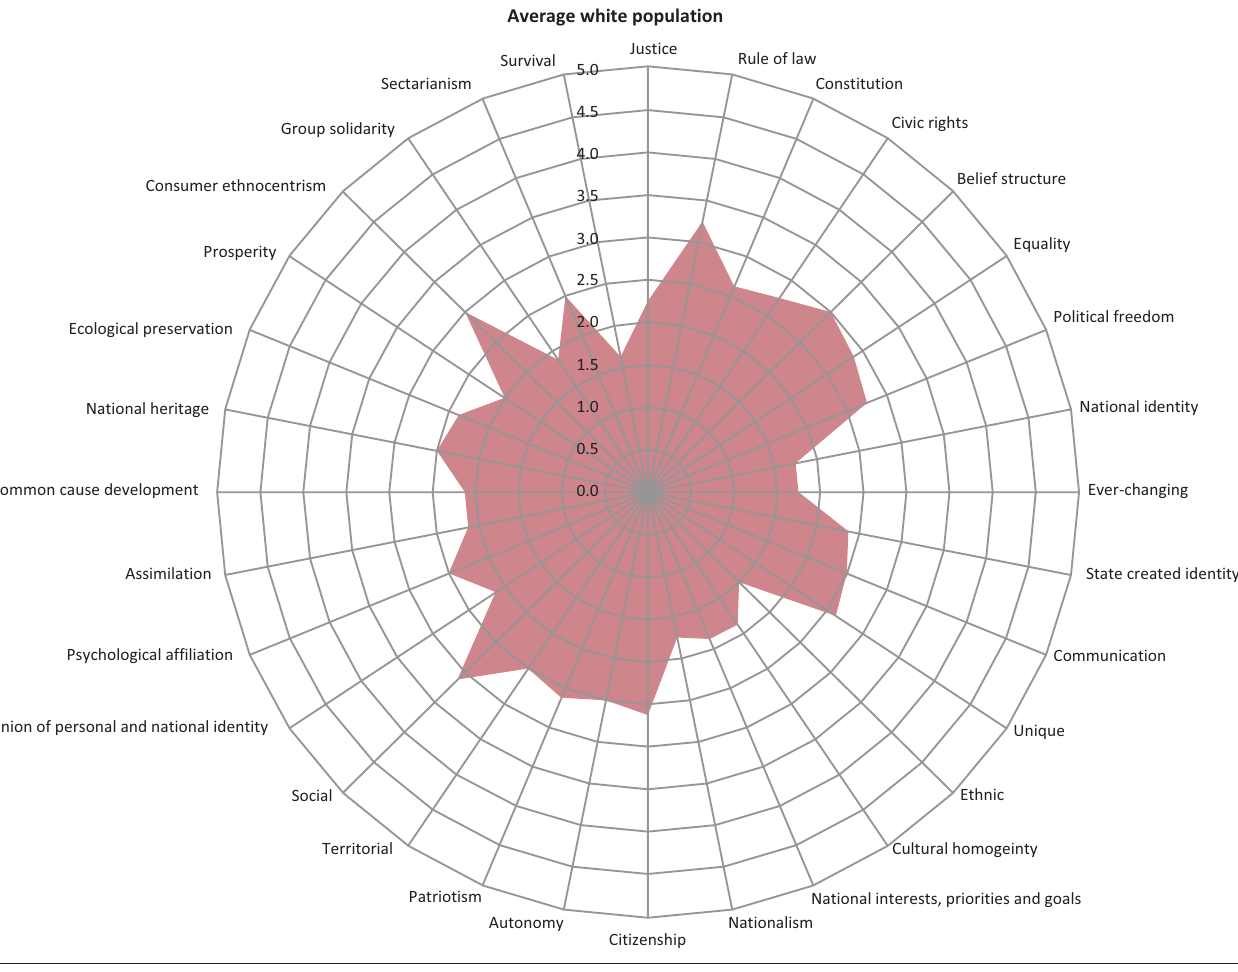
FIGURE 2: Spidergram depicting the extent of the indicators of national identity (white